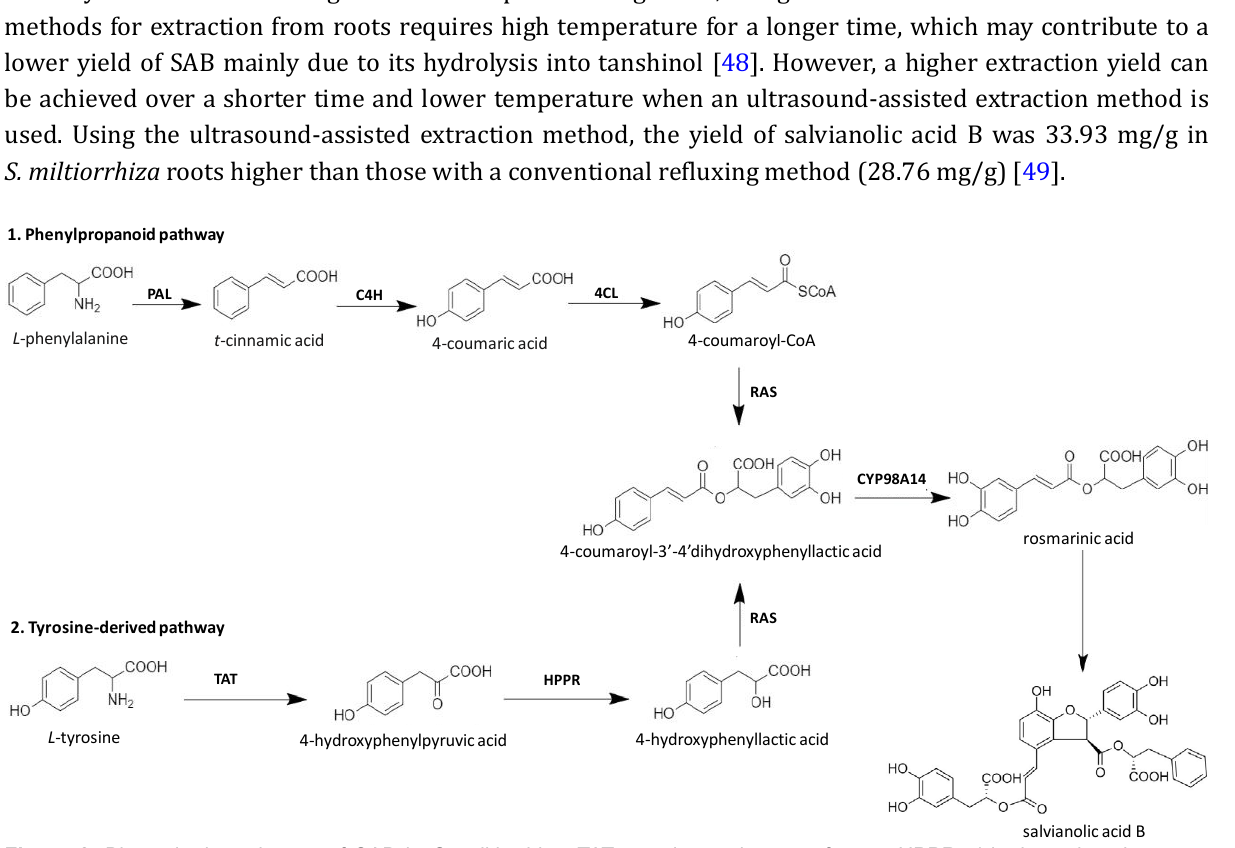
Figure 2. Biosynthetic pathways of SAB in S. miltiorrhiza . TAT: tyrosine amino transferase; HPPR: 4-hydroxyphenylpyruvate reductase; PAL: phenylalanine ammonia-lyase; C4H: cinnamic acid 4-hydroxylase; 4CL: 4-coumarate CoA ligase; RAS: rosmarinic acid synthase; CYP98A14: cytochrome P450-dependent